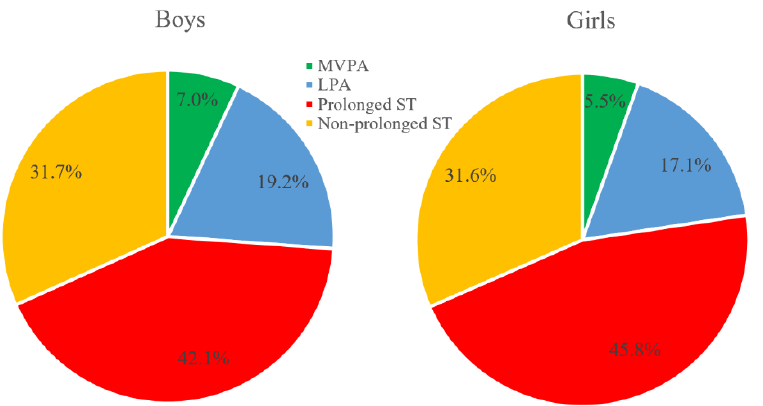
Figure 1. The proportions of prolonged ST, non-prolonged ST, LPA, and MVPA, stratified by gender. Table 2. Descriptive characteristics of ST and